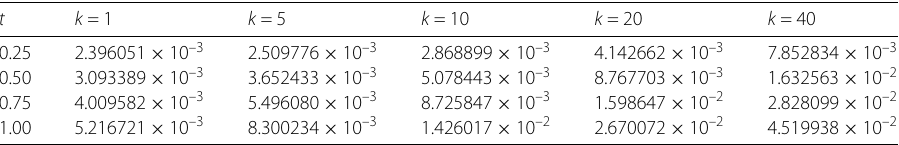
1 (cid:8) , τ = kh ) 1 ( h = 160 h